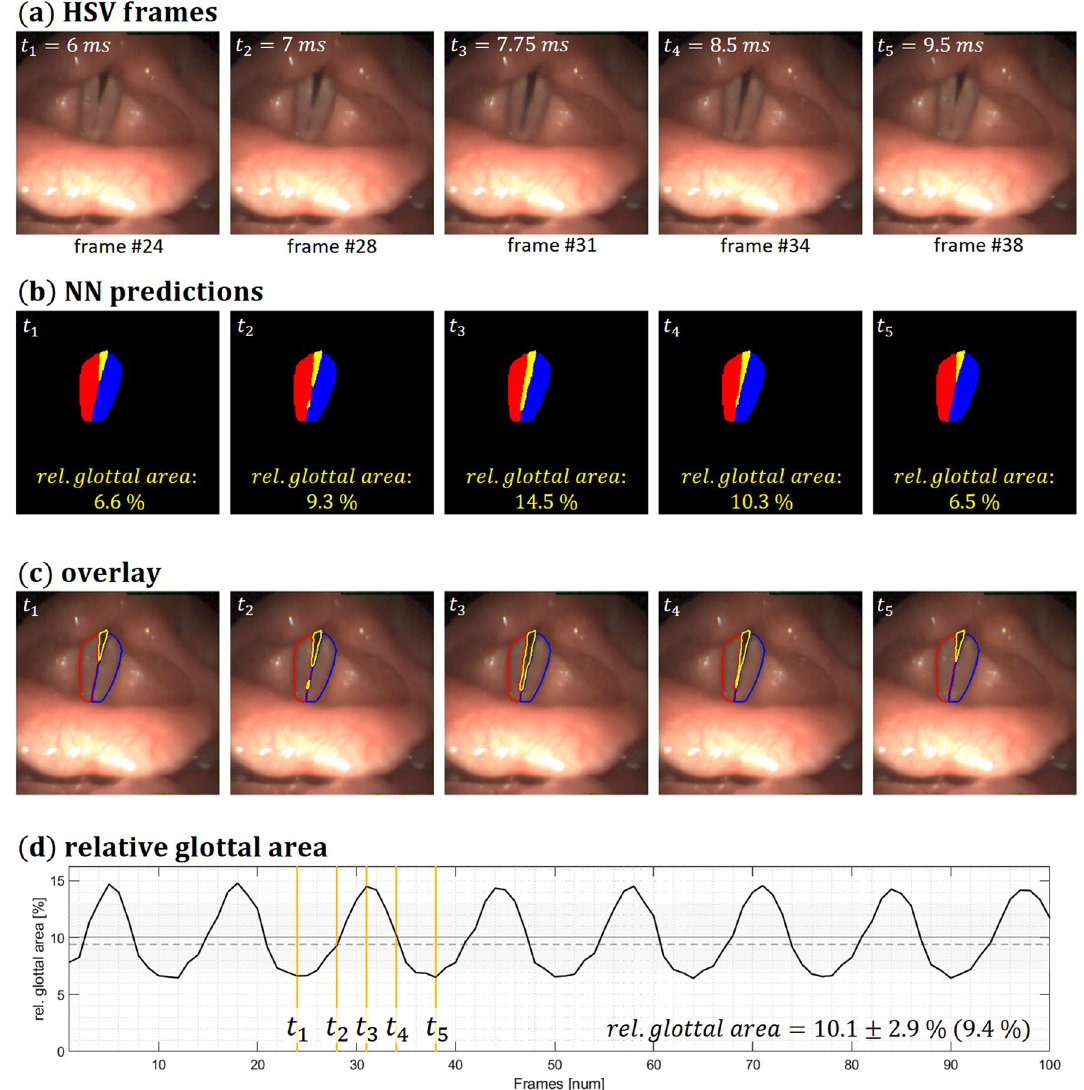
Figure 2. Individual images of the tracking of the vocal folds results and overlays for a single subject with a rear glottal gap: HSV frames; neural network predictions; overlays of predictions on the HSV images; and relative glottal area over time, with yellow markings of the 5 images, made by Fehling et al. using the open- source convolutional neural network, with the U-LSTM^ce-5 architecture, on subjects/videos from our database (reproduced with the approval of the Danish weekly journal for medical doctors ”Ugeskr Læger 2022;184:V02210146 ″